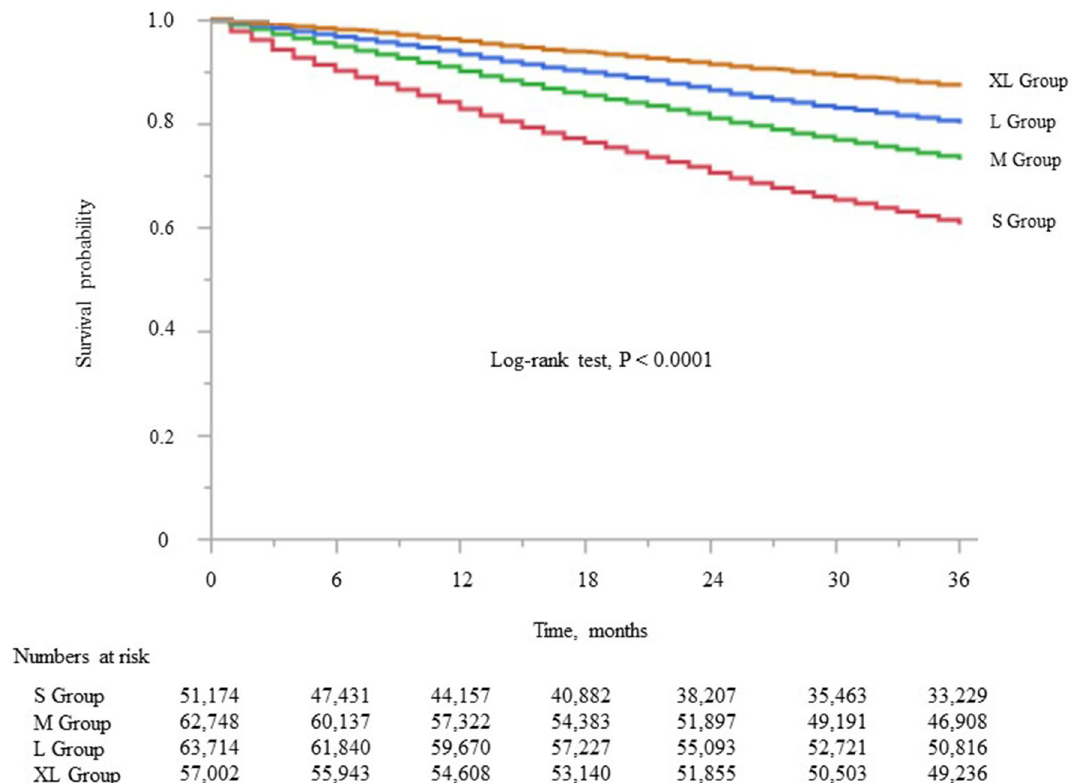
Figure 2. Kaplan–Meier survival curve for all-cause mortality stratified according to dialyzer surface area. S group, small dialyzer surface area, < 1.5 m 2 ; M group, medium dialyzer surface area, 1.5 m 2 ; L group, large dialyzer surface area, 1.6 to < 2.0 m 2 ; XL group, extra-large dialyzer surface area, ≥ 2.0 m 2